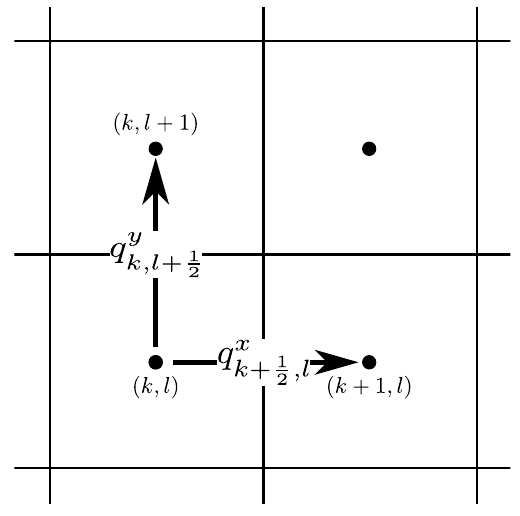
Fig. 1. Basic grid setup and definition of